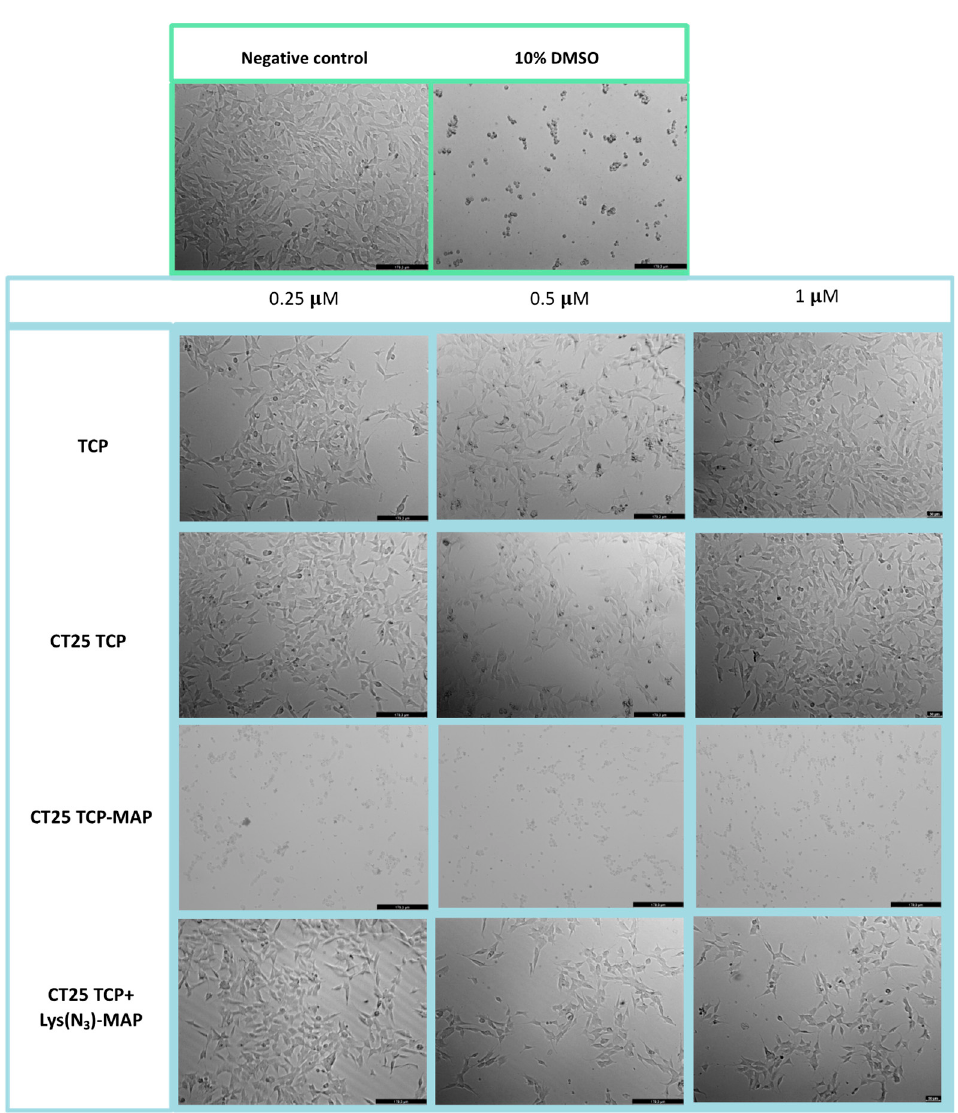
Figure 12. Microscope cellular visualization through Leica DFC350 FX of treatment with negative control (ultra ‐ purified H 2 O), positive control (10% DMSO), free drug, and NLC ‐ loaded formulations control (ultra-purified H 2 O), positive control (10% DMSO), free drug, and NLC-loaded formulations (CT25TCP, CT25TCP ‐ MAP and CT25 TCP + Lys(N 3 ) ‐ MAP) on SH ‐ SY5Y cell line at a concentration (CT25TCP, CT25TCP-MAP and CT25 TCP + Lys(N 3 )-MAP) on SH-SY5Y cell line at a concentration of of 0.25, 0.5, and 1 μ M. 0.25, 0.5, and 1 µ